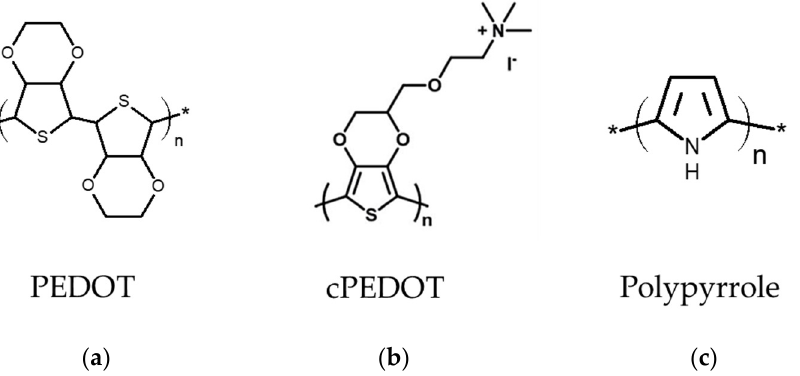
Figure 5. The molecular structures of the conductive polymer of ( a ) PEDOT [35], ( b ) cPEDOT [66], and ( c ) Polypyrrole [67].